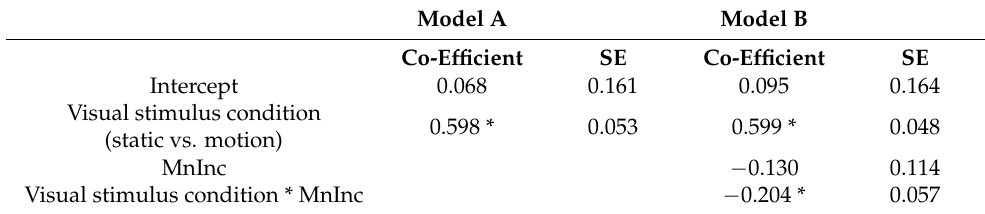
Table 1. Modelling effect visual stimulus condition (static versus motion), and cortisol awakening response on postural sway.